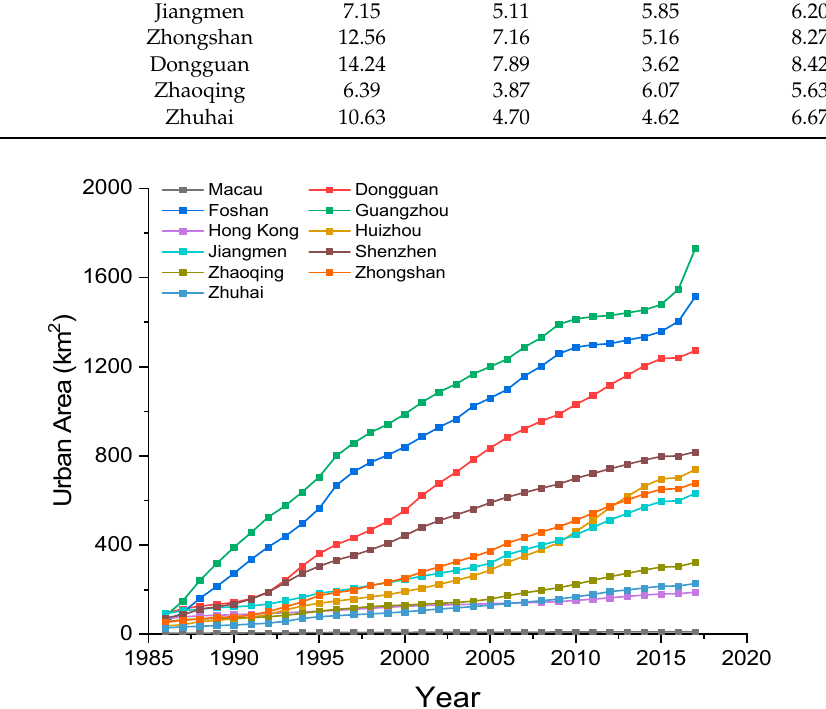
Figure 4. The temporal changes of urban areas of the cities in the GBA during 1986–2017.